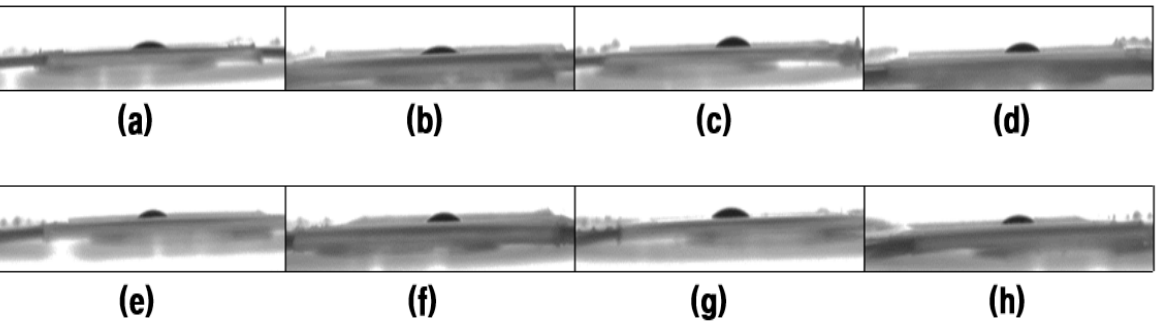
Figure 11. Oil contact angles for all tested PVA membranes.